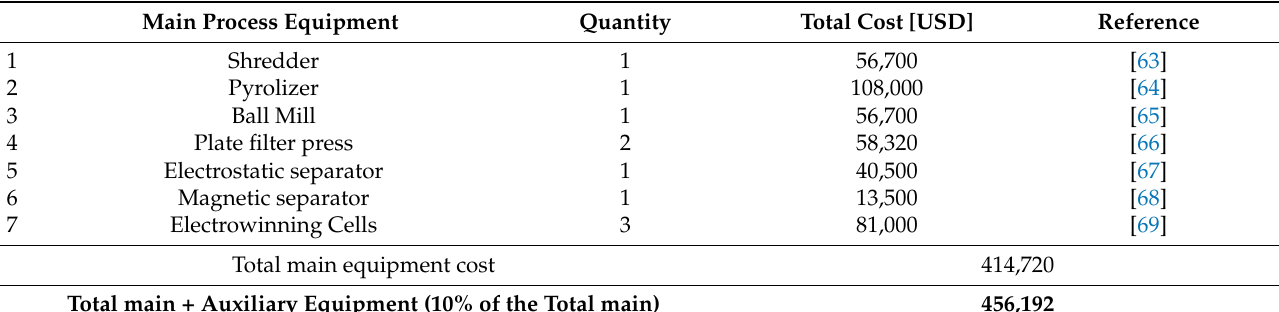
Table 5. Main process equipment costs for the base case, quoted on the website of international suppliers, with import and shipping fees